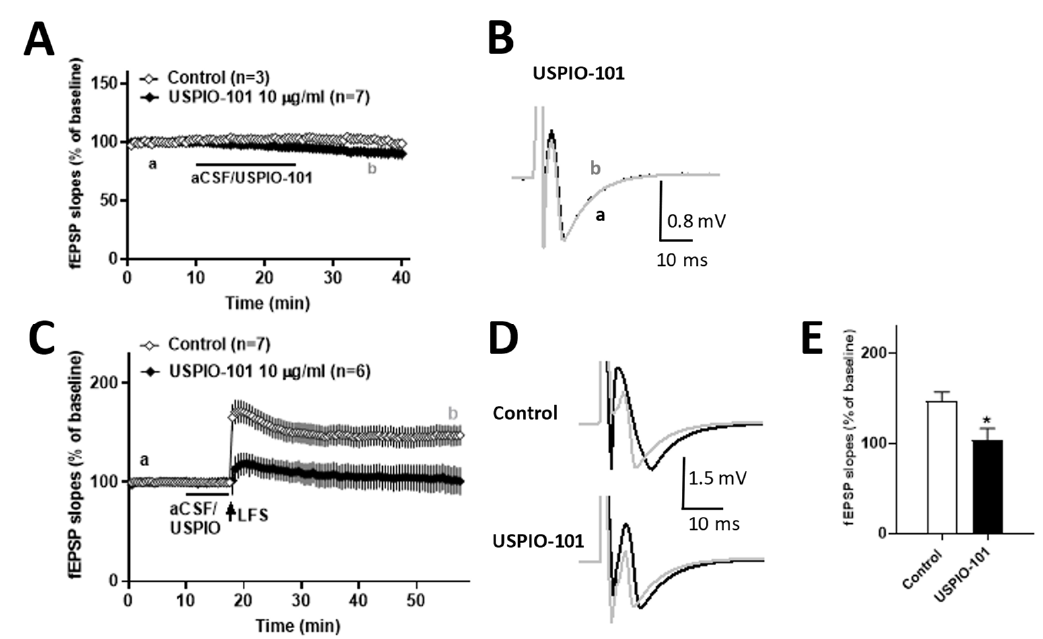
Figure 4. The effect of USPIO-101 on basal transmission ( A ) and spinal cord LTP ( B , C ) at the spinal cord superficial dorsal horn synapses, respectively. ( A ) After baseline recording for 10 min, USPIO-101 (10 µg/mL) was applied for another 15 min, then washed for 15 min. No difference was observed in the basal transmission after application of USPIO-101 to the spinal cord superficial dorsal horn synapses. ( C ) Time courses of the slope of fEPSPs recorded before and after LFS (arrow) in spinal cord slices. Drugs: USPIO-101 (10 µg/mL) was applied for 7.5 min before LFS stimulation. ( E ) The bar graph represents the magnitudes of potentiation, which averaged 20 fEPSPs recorded 30~40 min after LFS. *: p < 0.05 vs. control group (one-way ANOVA). ( B , D ) The traces shown in the graph are averaged 20 recordings of fEPSPs at times a and b in each group. The expression and analysis of the baseline fEPSP slope are the same as Figure 2. n indicates the number of slices recorded.